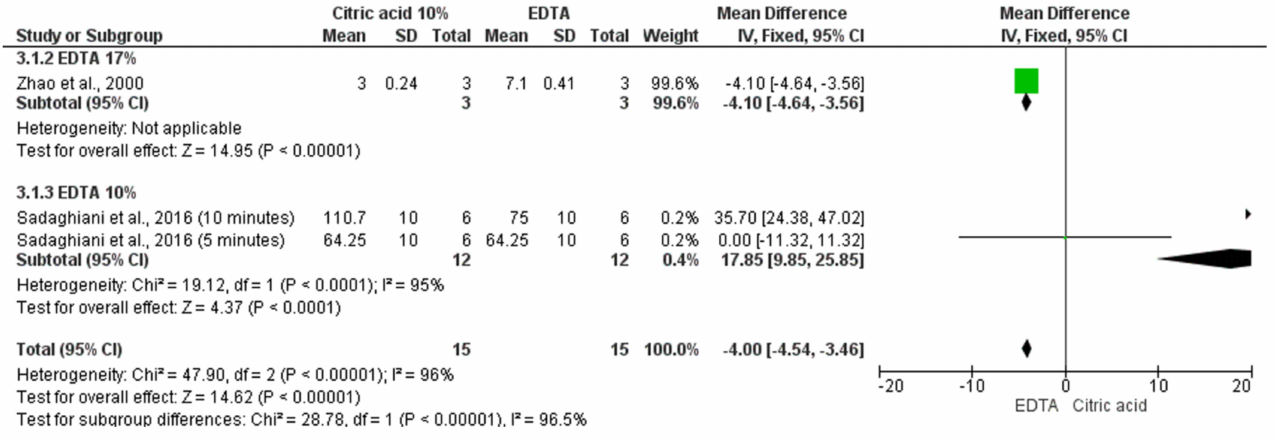
Figure 4. Forest plot for comparisons of TGF- β 1 detected by the immunogold method after exposure to EDTA versus 10% citric